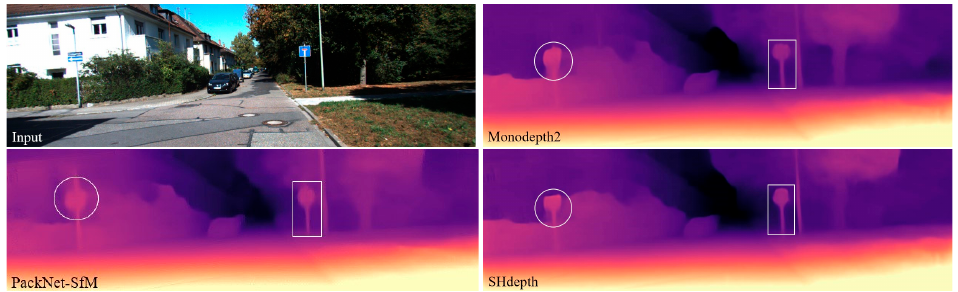
Figure 1. Depth prediction from a single image. We compared our self-supervised method, SHdepth, with Monodepth2 [11] and PackNet-SfM [17]. Our model produces a higher quality and sharper depth map.